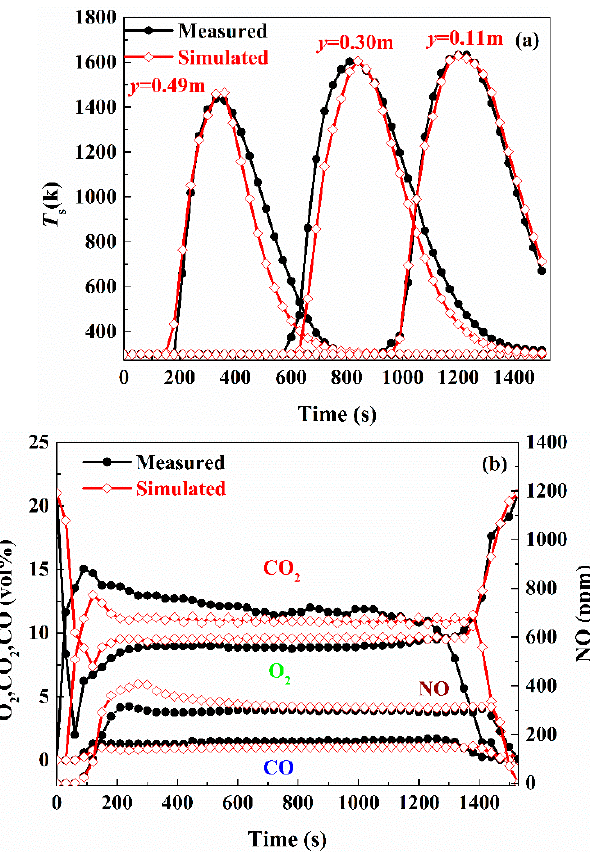
Figure 2. Comparison between the measured data and simulation results of 3.8% coke: ( a ) Temperature profiles of solid material; ( b ) combustion gas compositions.